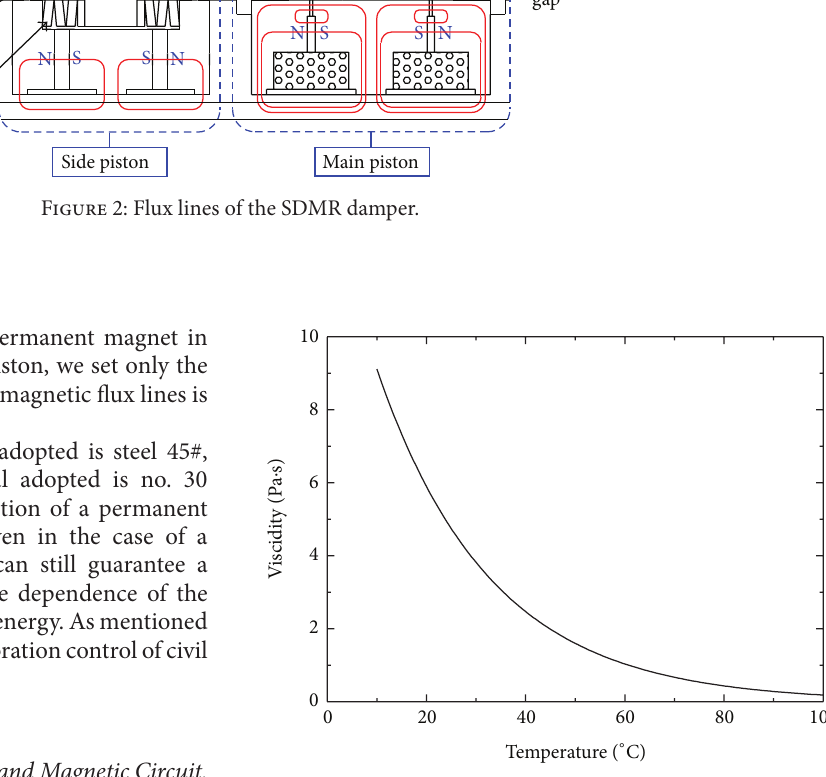
Figure 3: Variety trend of SDMR damper’s